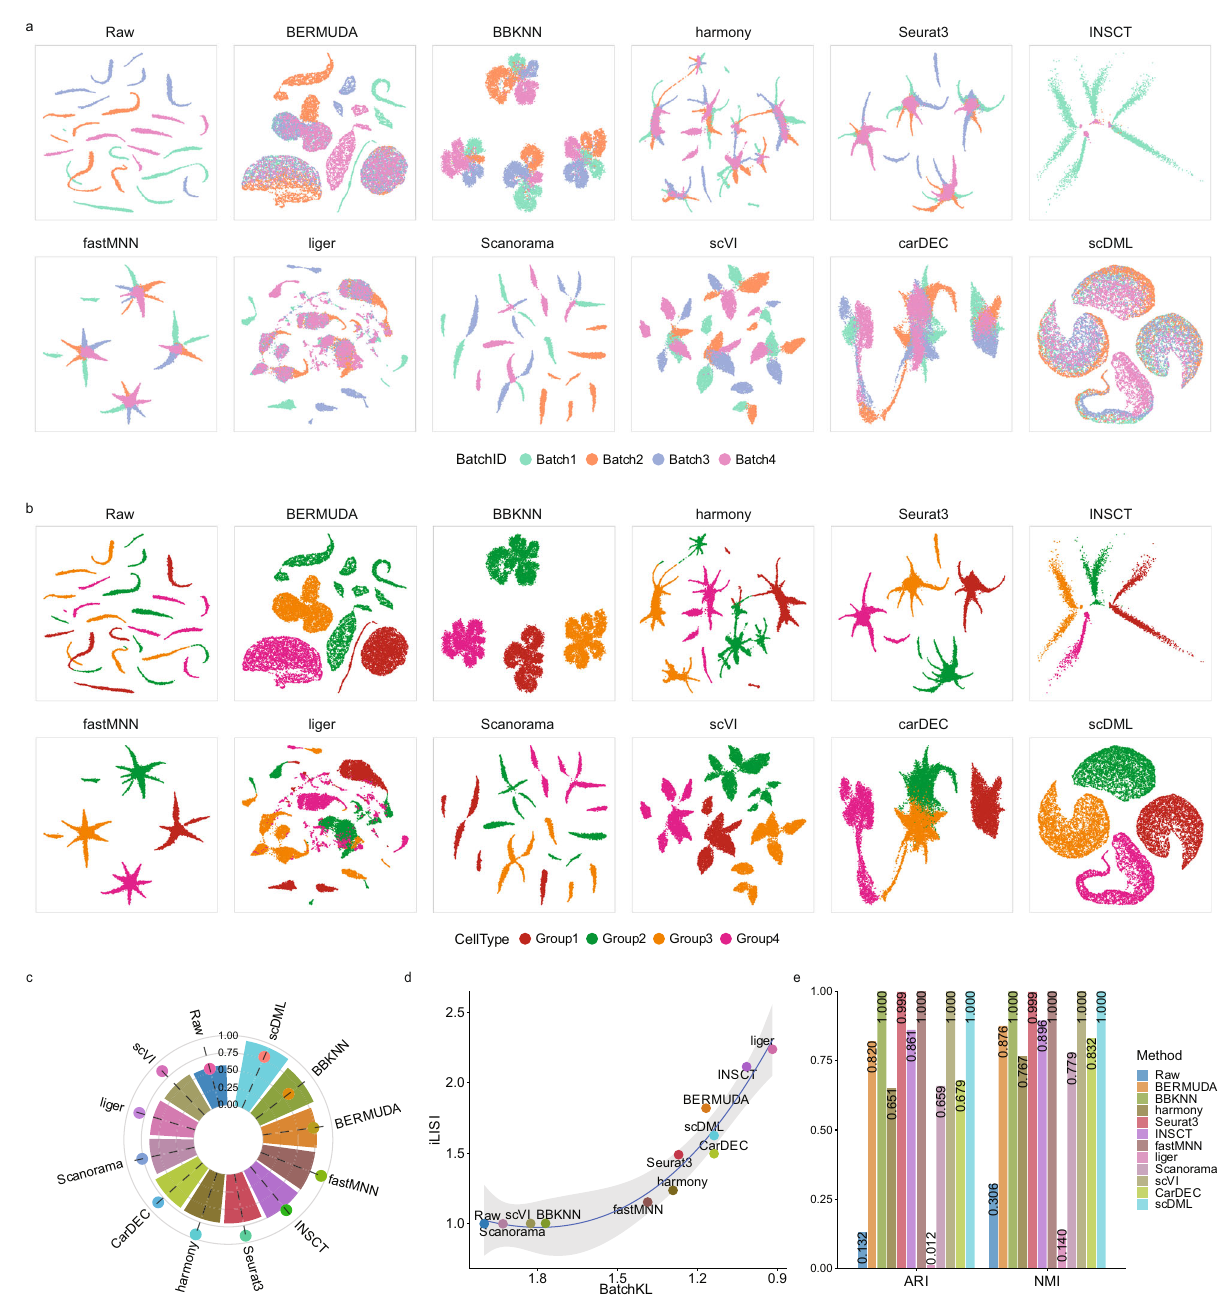
Fig. 2 | scDML removesbatch effects and keeps thebiologicaldifference inthe complex simulated scRNA-seq data. a UMAP embedding computed from com- pared methods, in which the points are colored by batch. b UMAP embedding computed from compared methods, in which the points are colored by cell type. c Barplotshowsthe value of ASW_celltype and ASW_batch,inwhichthe barheight denotes the value of ASW_celltype and the point height denotes the value of